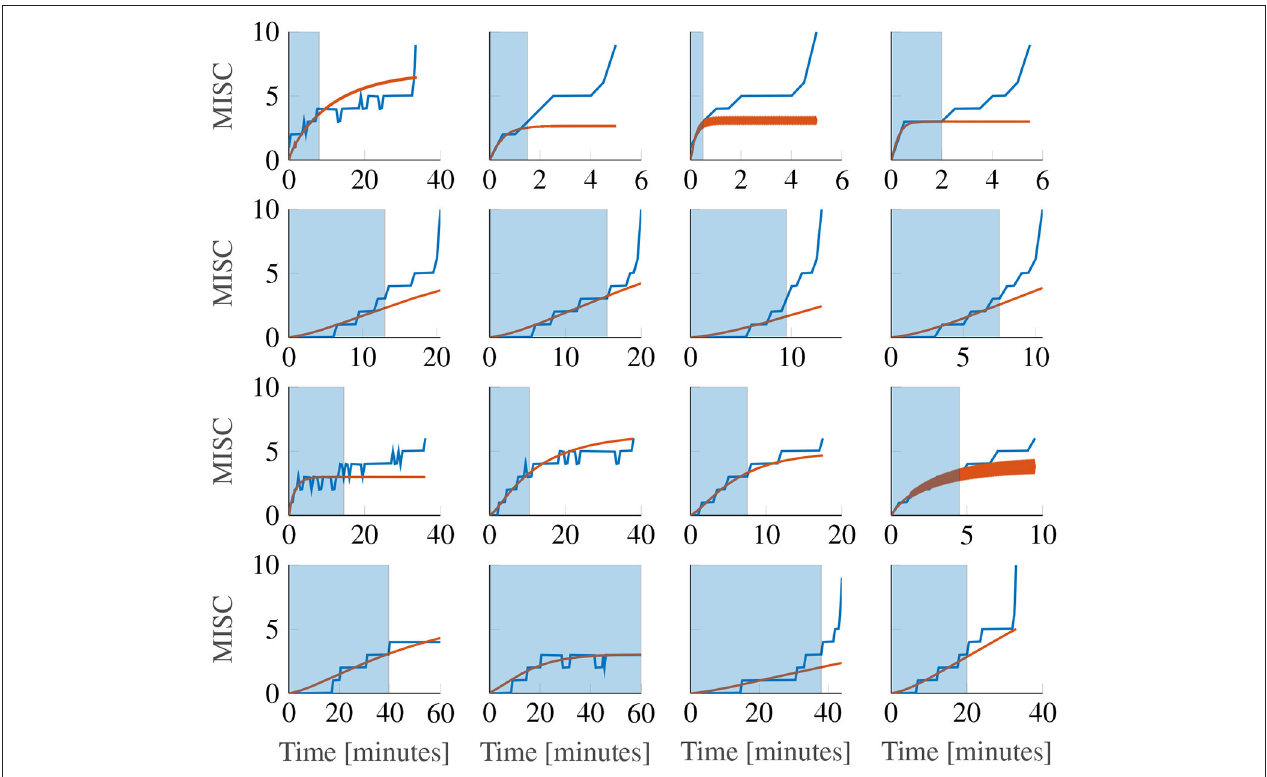
FIGURE 9 | Representative sample of extrapolations from MISC 3 to the end of the first motion phase, for the Oman model. The columns show responses for each amplitude condition, increasing in magnitude from left to right. The rows show results for participants 11, 12, 13, and 14. The blue shaded area gives the observations the model uses to make